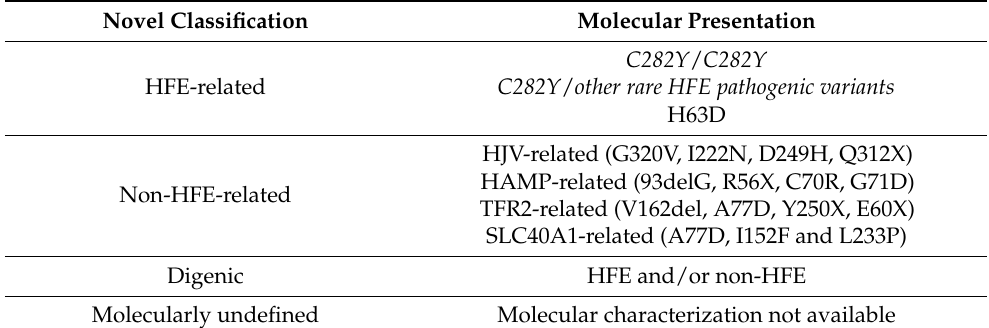
Table 2. New classification of hemochromatosis. Novel